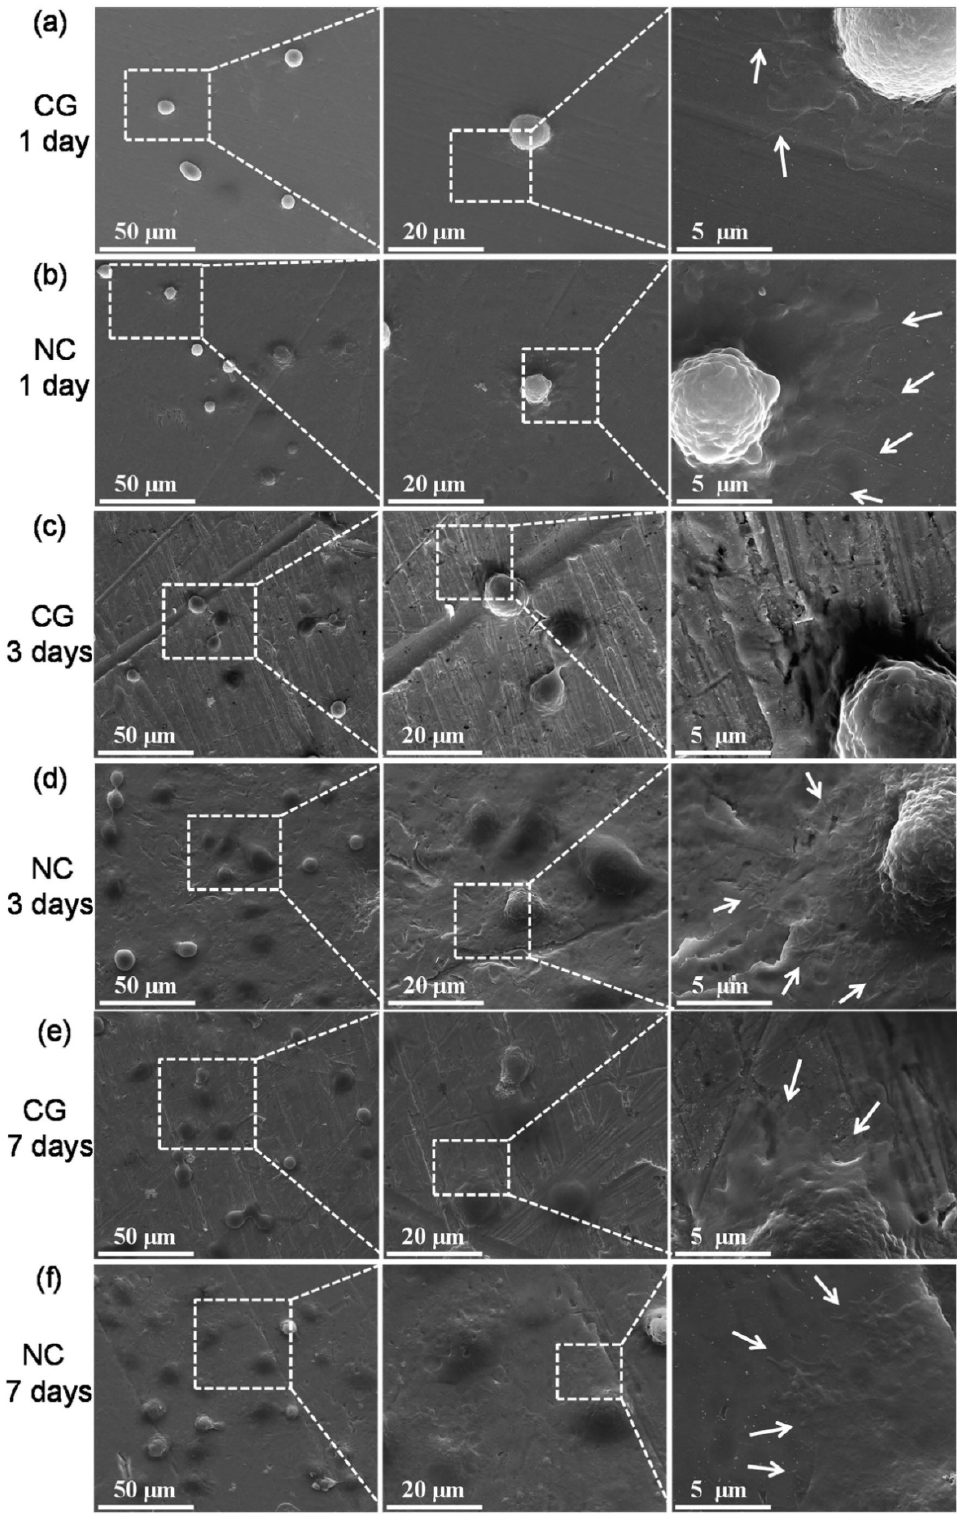
Figure 4. Typical morphologies of hFOBl.19 cells cultured on: ( a , c , e ) CG and ( b , d , f ) NC Ta surfaces for ( a , b ) 1 day, ( c , d ) 3 days, and ( e , f ) 7 days. Arrows indicate filopodia extensions. Reprinted with permission from Ref. [55].